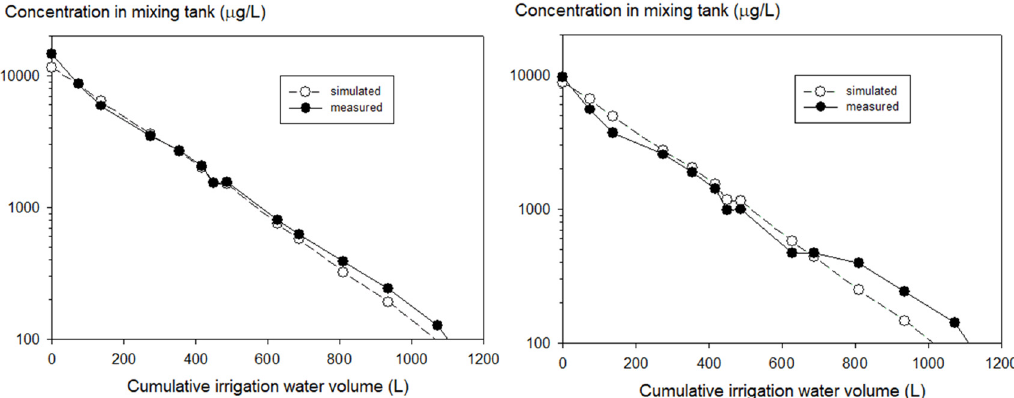
Figure 6. Measured and simulated concentrations of imidacloprid ( left ) and pymetrozine ( right ) in the mixing tank as a function of the cumulative volume of irrigation water, i.e., the water that was pumped out of the mixing tank. Irrigation occurred in batches every 2–3 h, and the mixing tank was refilled. Concentrations were measured in duplicate, and the average value is shown in the graphs.